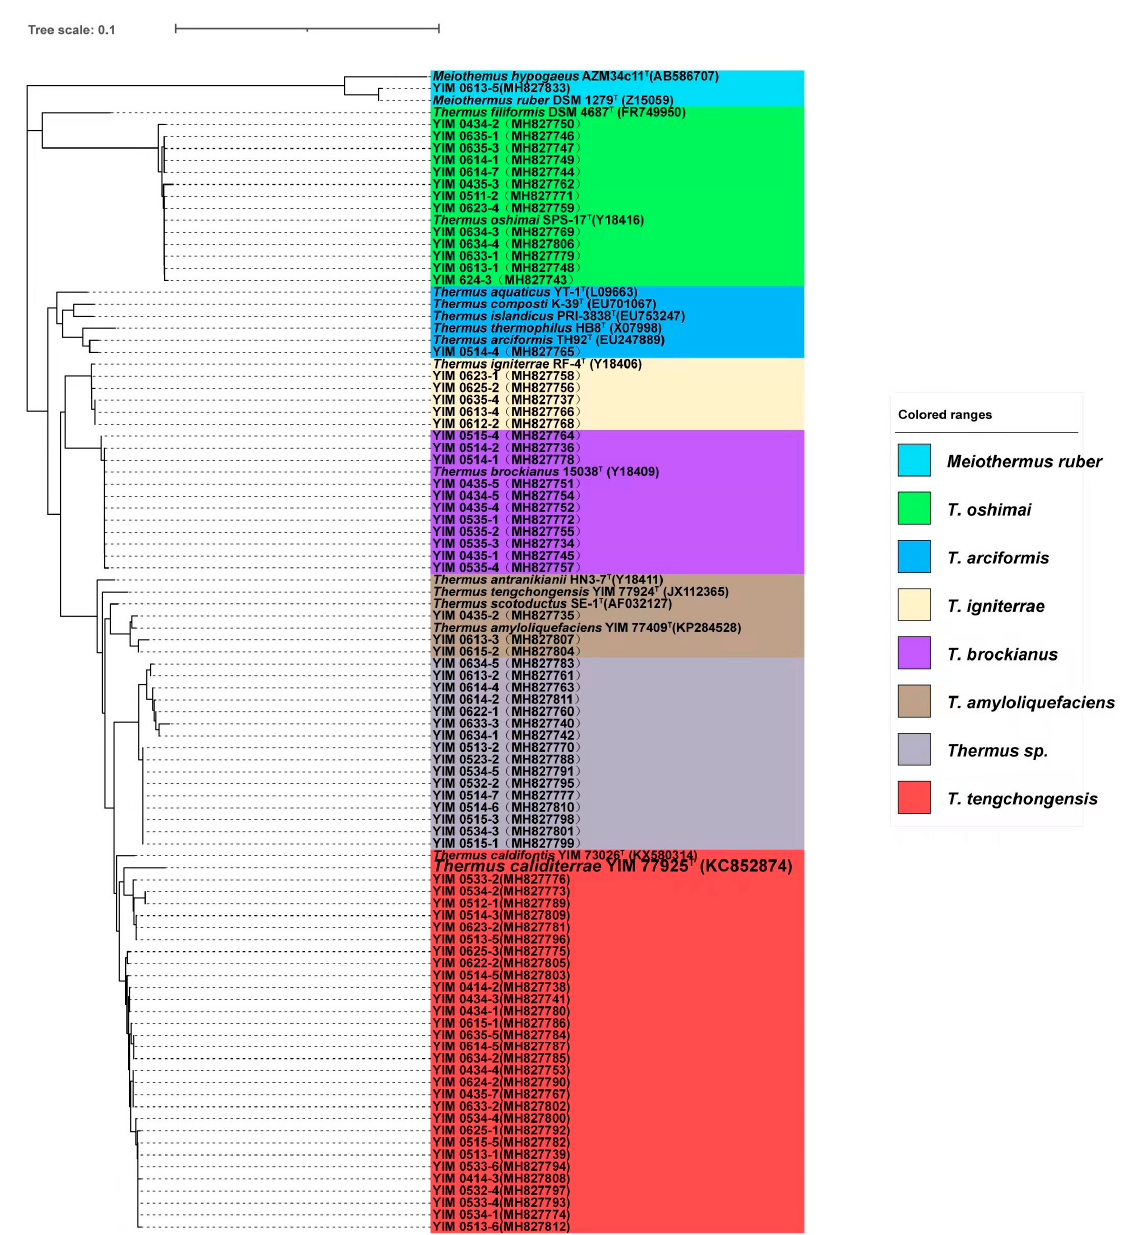
Figure 2. The phylogenetic tree for the culturable Thermus strains in the Lincang geothermal region. Numbers at nodes indicate bootstrap values (>50%) based on a neighbor-joining analysis of 1000 resampled datasets. The vertical scale bar in the middle represents 0.1 substitutions per nucleotide position.